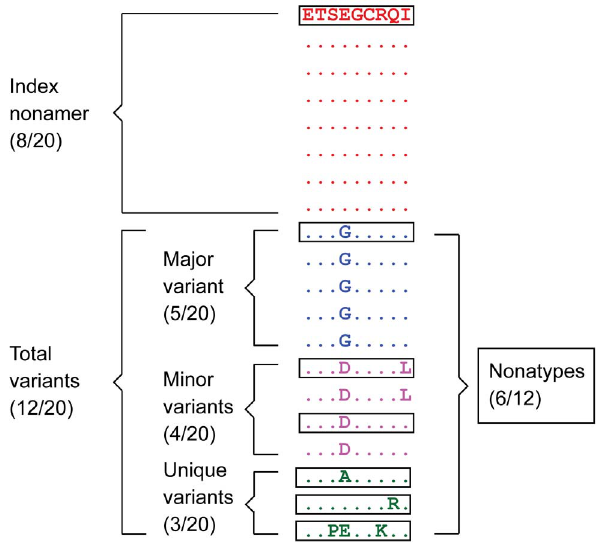
Figure 1. Definitions of HIV-1 clade B nonamer sequence motifs. The different sequence motifs of the aligned HIV-1 clade B isolates were identified as shown with 20 sequences of a model nonamer position. The ‘‘Index’’ nonamer is the most prevalent sequence, present in 8 of the 20 isolates. The ‘‘Major’’ variant is the most common variant of the index (5/20). ‘‘Minor’’ variants are multiple different repeated sequences, each with incidences less than that or occasionally equal of the major variant. ‘‘Unique’’ variants are those represented by a single aligned sequence. ‘‘Nonatypes’’ (boxed) are the distinct variant sequences at a given nonamer position; in this example one of major, two of minor, and three of unique.